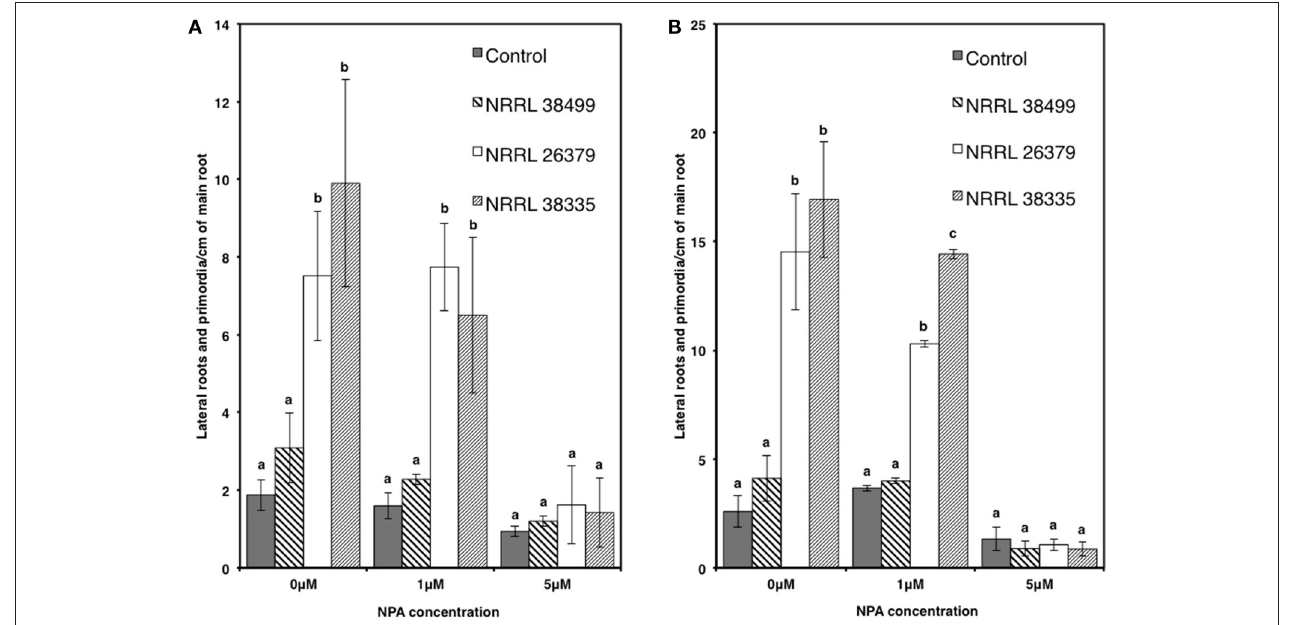
FIGURE 8 | Effect of F. oxysporum volatiles on A. thaliana lateral root development in the presence of NPA. Lateral root density (both lateral roots and lateral root primordia) of Col-0 containing DR5::GUS in the presence of 0, 1, and 5 µ M NPA was determined after cocultivation with no fungus (control), NRRL 38499, NRRL 26379, and NRRL 38335 for 7 (A) and 14 (B) days. Means and standard errors for two biological replicates per treatment, with five seedlings per replicate, are shown. Different letters on columns denote statistically significant differences within each treatment by one-way analysis of variance.